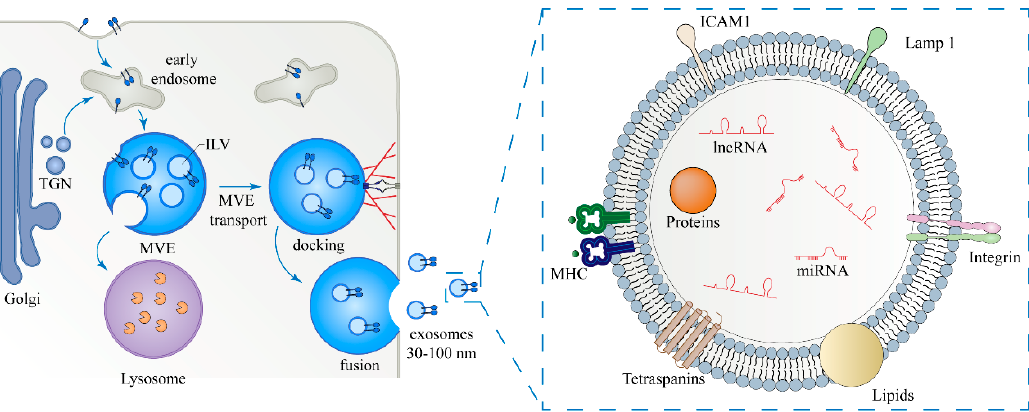
Figure 1. Biogenesis, secretion, and cargos of exosomes. Exosomes are formed as intraluminal vesicles (ILVs) by endocytosis at the plasma membrane (PM), budding into early endosomes and multivesicular body (MVB). Cargos, which are targeted to MVEs, originate from endocytosis at the PM or from the early endosomes via the trans-Golgi network (TGN). The fate of MVBs can be either fusion with lysosomes or docking and fusion with the plasma membrane, which allows the release of exosomes to the extracellular milieu. Exosome cargo contains non-coding RNAs (including microRNAs and lncRNAs), proteins, and lipids. TGN: trans-Golgi network; ICAM-1: intercellular cell adhesion molecule-1; and MHC: major histocompatibility complex.